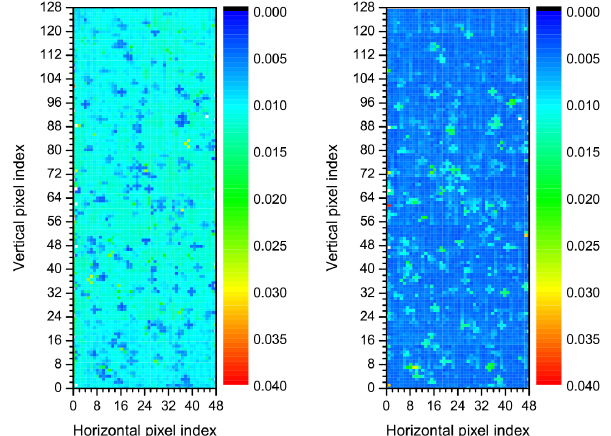
Figure 6. GLORIA so-called deep space (10 ◦ elevation) spec- trum of a single detector pixel of 13 September 2012, 07:20UT at 40.8 ◦ S, 15.0 ◦ E. For the spectrum six subsequent measurements have been co-added. Black: measured spectrum. Red: spectrum af- ter removal of atmospheric contribution. Green: smoothed (4cm − 1 ) version of the red